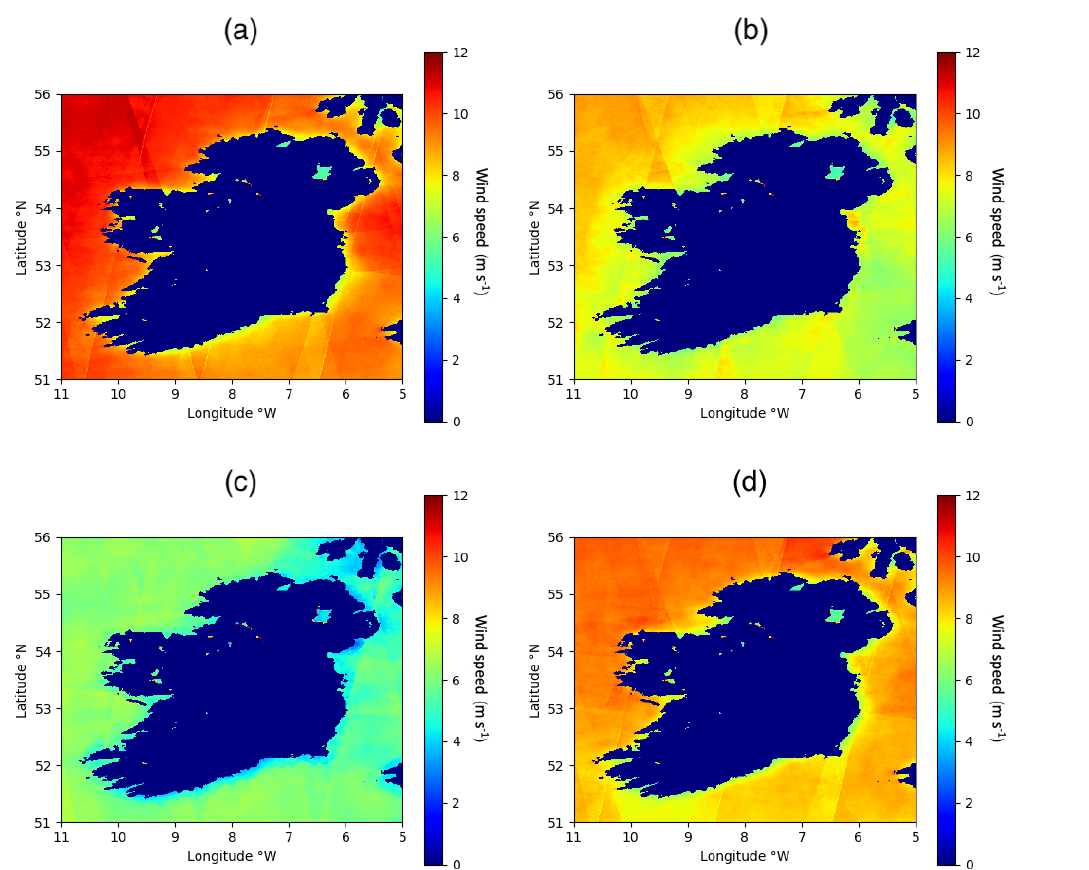
Figure 9. Seasonal average wind speed off Ireland over a 2-year period running from May 2017 to May 2019 retrieved using the Sentinel-1 SAR Level 2 OCN product: winter (a) , spring (b) , summer (c) and autumn (d) . Satellite tracks are visible, particularly in the northeast. These are an artefact of the